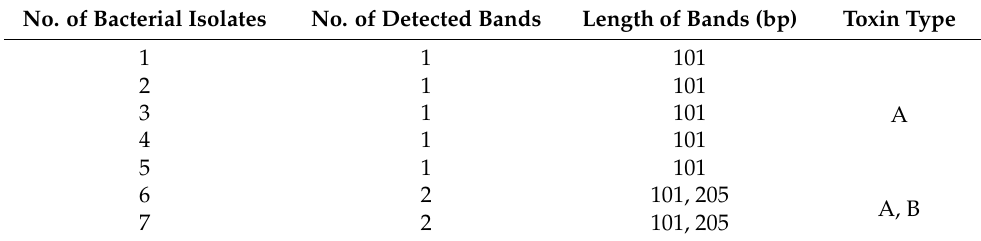
Table 6. The banding pattern for the seven studied bacterial isolates (isolated from the Gharbia governorate) using multiplex